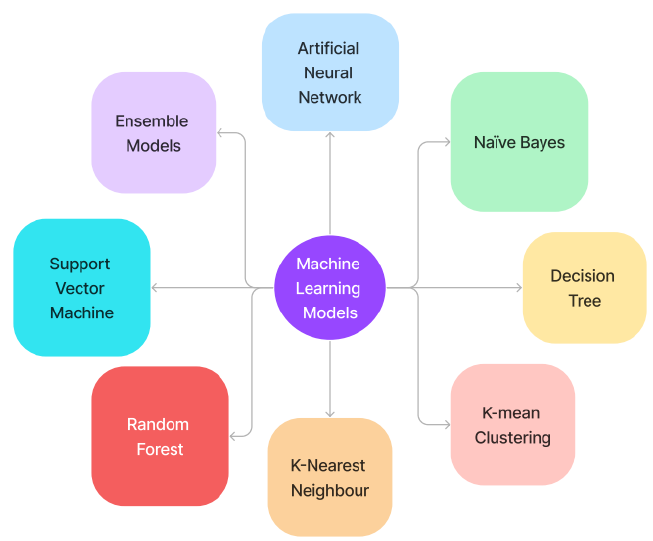
Figure 5. Machine Learning Models for Parkinson’s disease Diagnosis used in this review